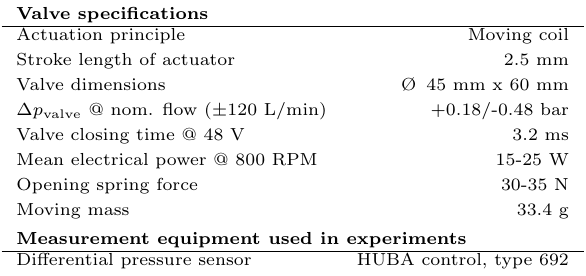
Table 3: Key specifications for the active check-valve PT and sensors used in experiments.